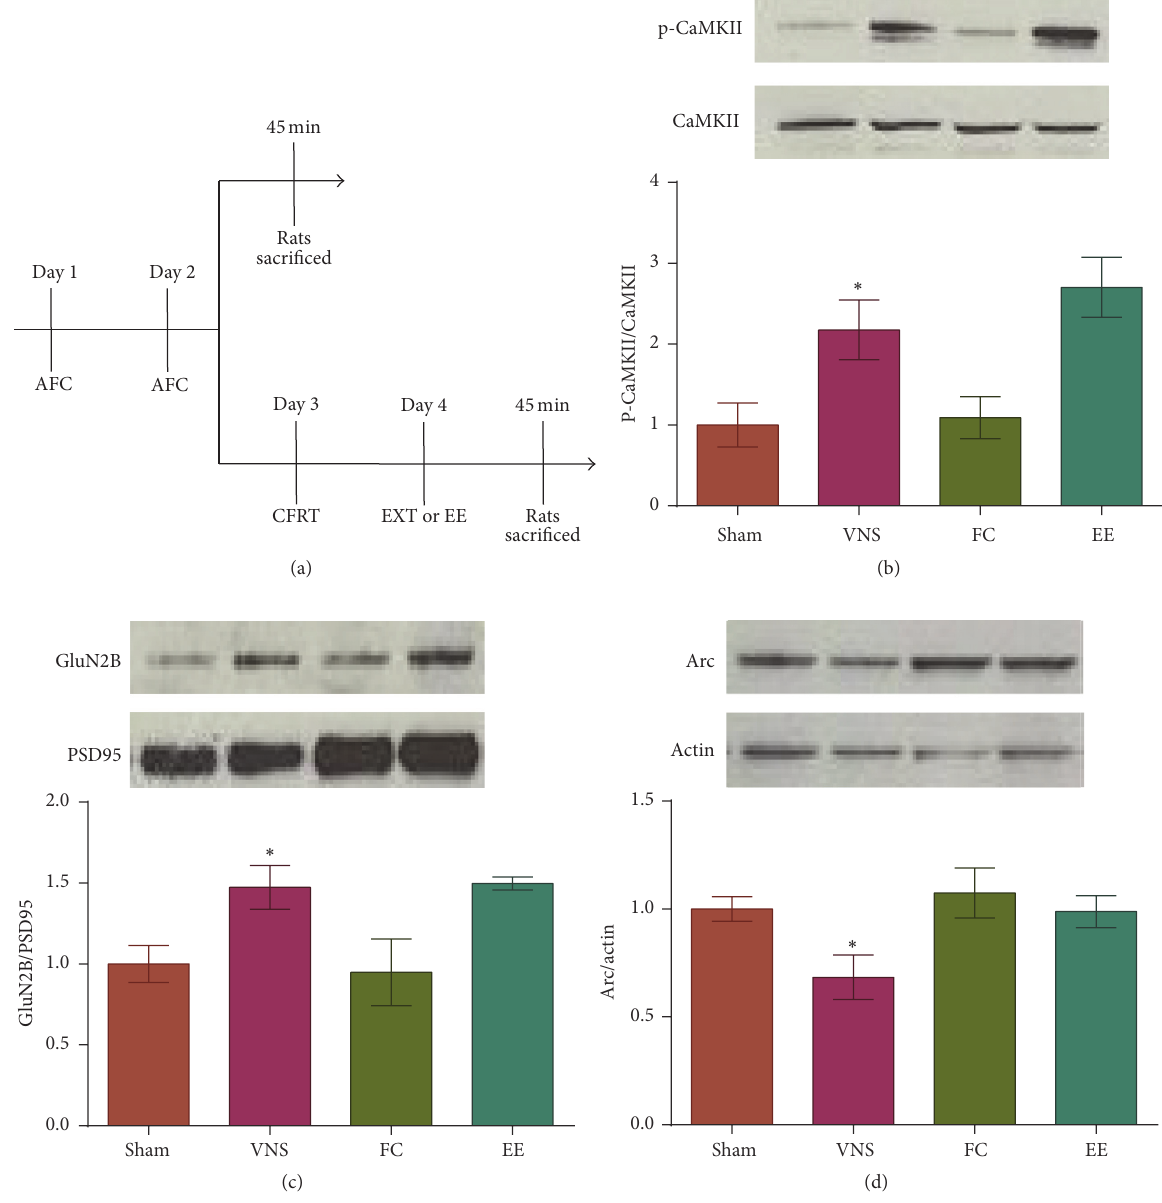
Figure 3: VNS accelerates molecular mechanisms of extinction learning. (a) Timeline of behavioral protocol. On days 1 and 2 rats were subjected to auditory fear conditioning (AFC). One cohort was sacrificed 45min after AFC. Another cohort underwent a conditioned fear response test (CFRT; day 3), followed by extinction training (EXT) or extended-extinction (EE) training (day 4), and was sacrificed 45 min later. (b-c) Rats given VNS during extinction training show higher levels of p-CaMKII and GluN2B compared to rats given sham during extinction training and rats that underwent auditory fear conditioning alone (FC; ∗ 𝑝 < 0.05 ) and do not differ from rats that underwent extendedextinction. (d) Rats given VNSduring extinctiontraining show lower levelsof Arcproteincompared to all other groups ( ∗ 𝑝 < 0.05